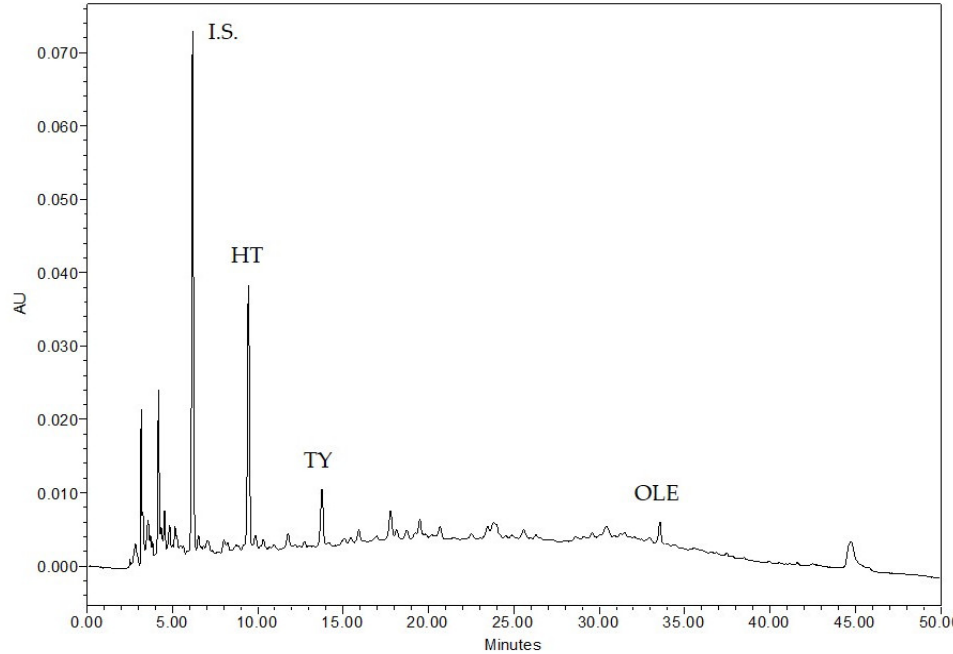
Figure 1. HPLC phenolic profile (at 280 nm) of OMW sample (I.S. = Internal Standard).